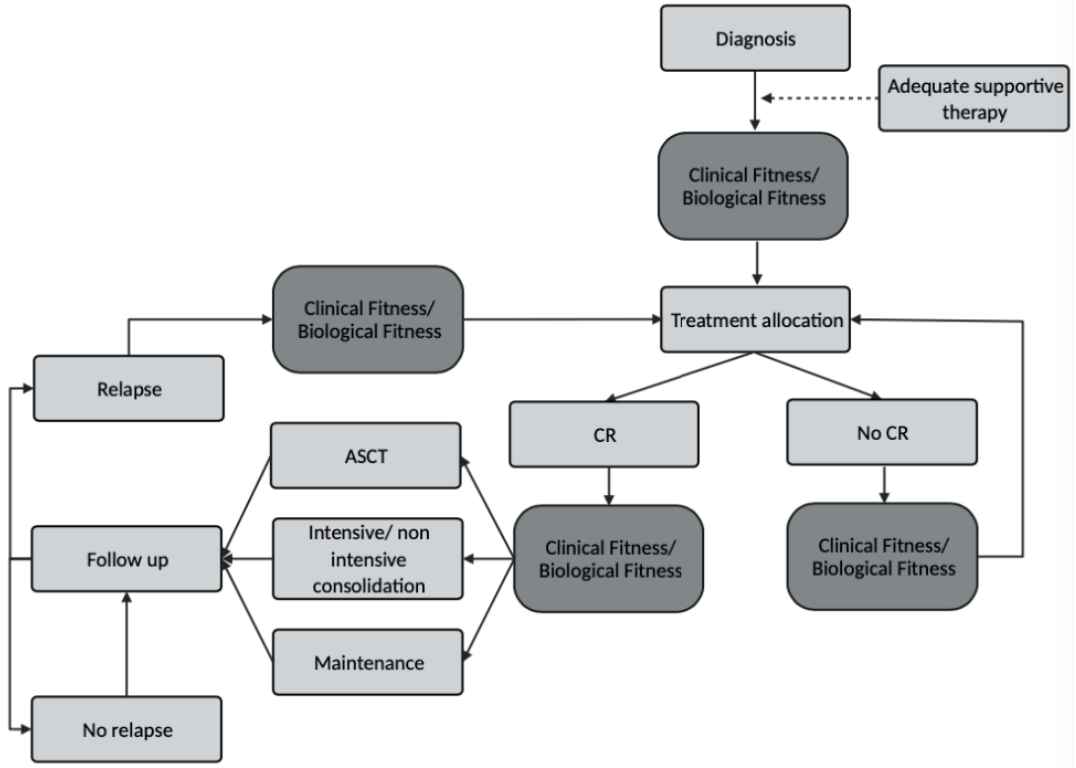
Figure 1. Critical time points for Clinical and Biological Fitness